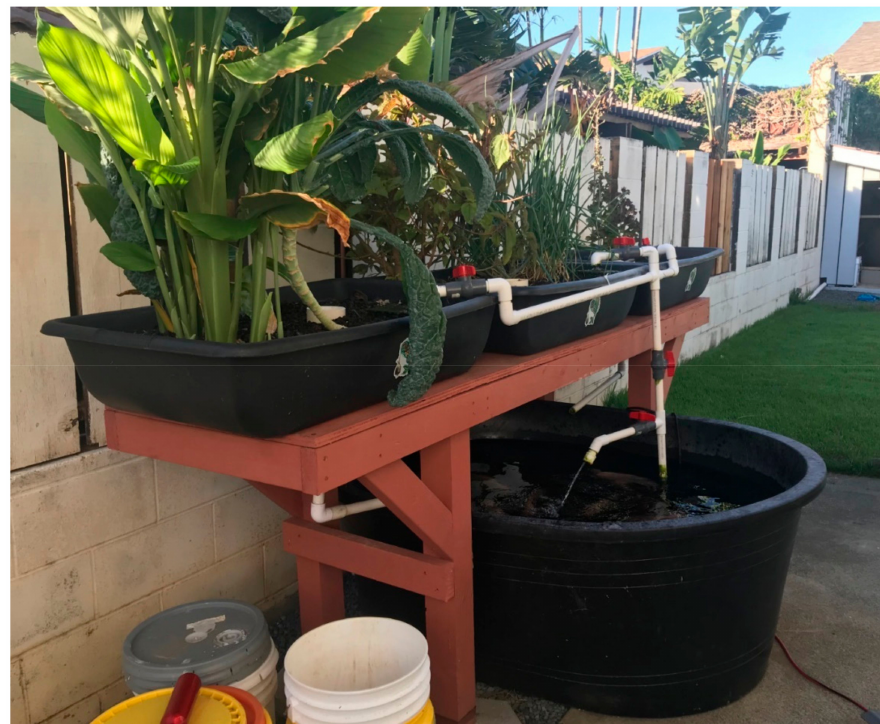
Figure 1. Backyard aquaponics